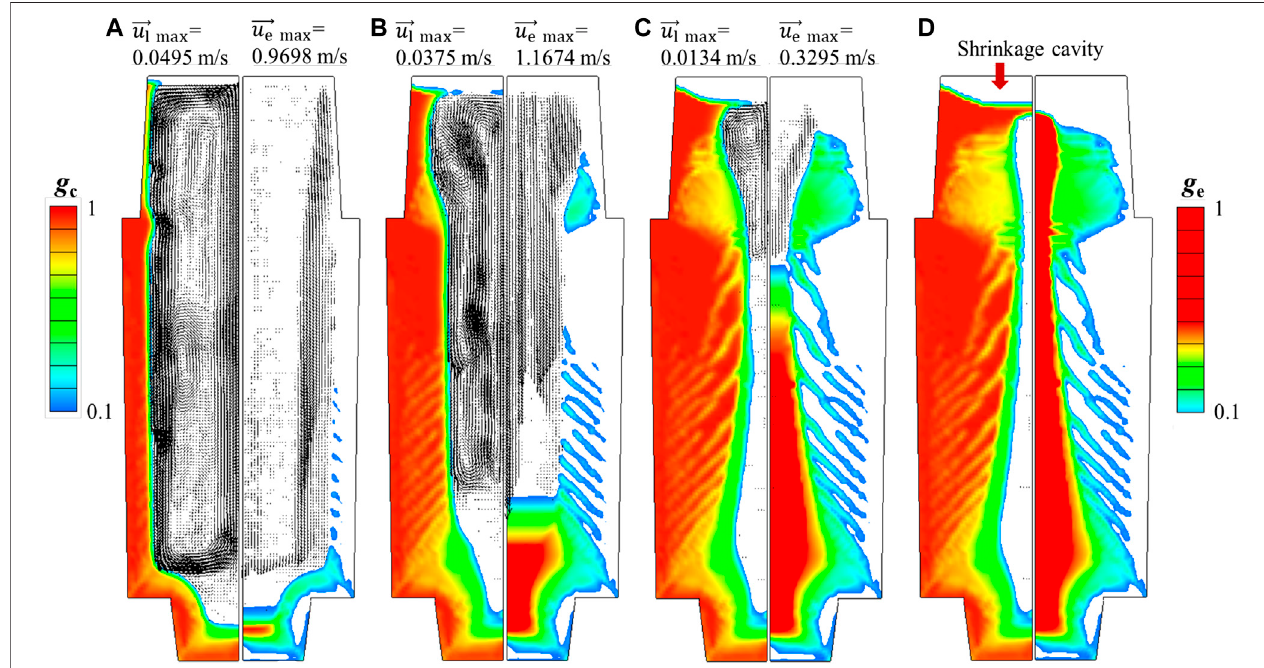
FIGURE 2 | Predicted solidi fi cation sequence of the four-phase shrinkage case in the 36-ton ingot at different times: (A) 0.5 h, (B) 2 h, (C) 5 h, (D) end of solidi fi cation. The left half shows the columnar volume fraction ( g c ), and the melt velocity ( u l , arrows). The right half shows the equiaxed volume fraction ( g e ), and the sedimentation velocity ( u e , arrows).